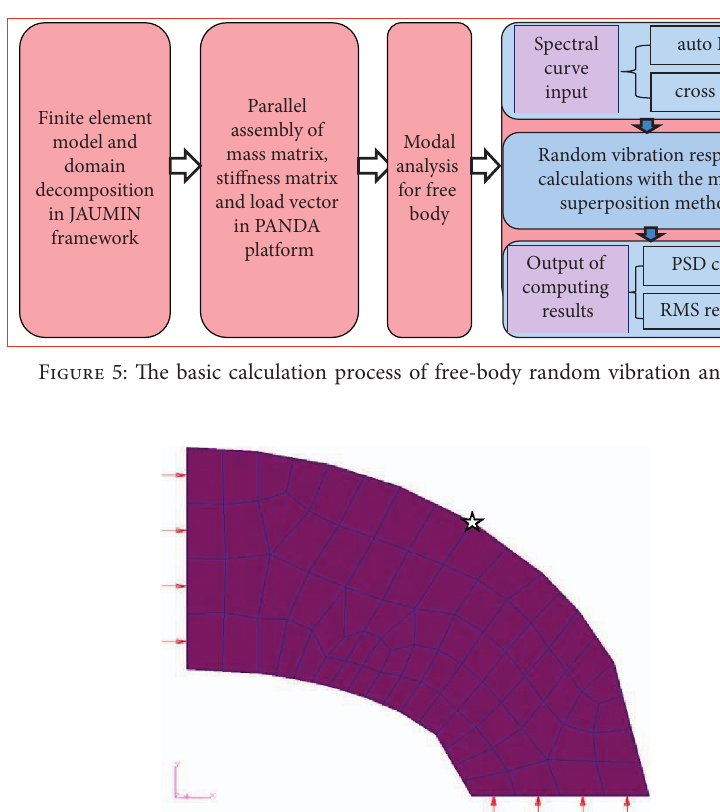
Figure 6: FEM of the sector